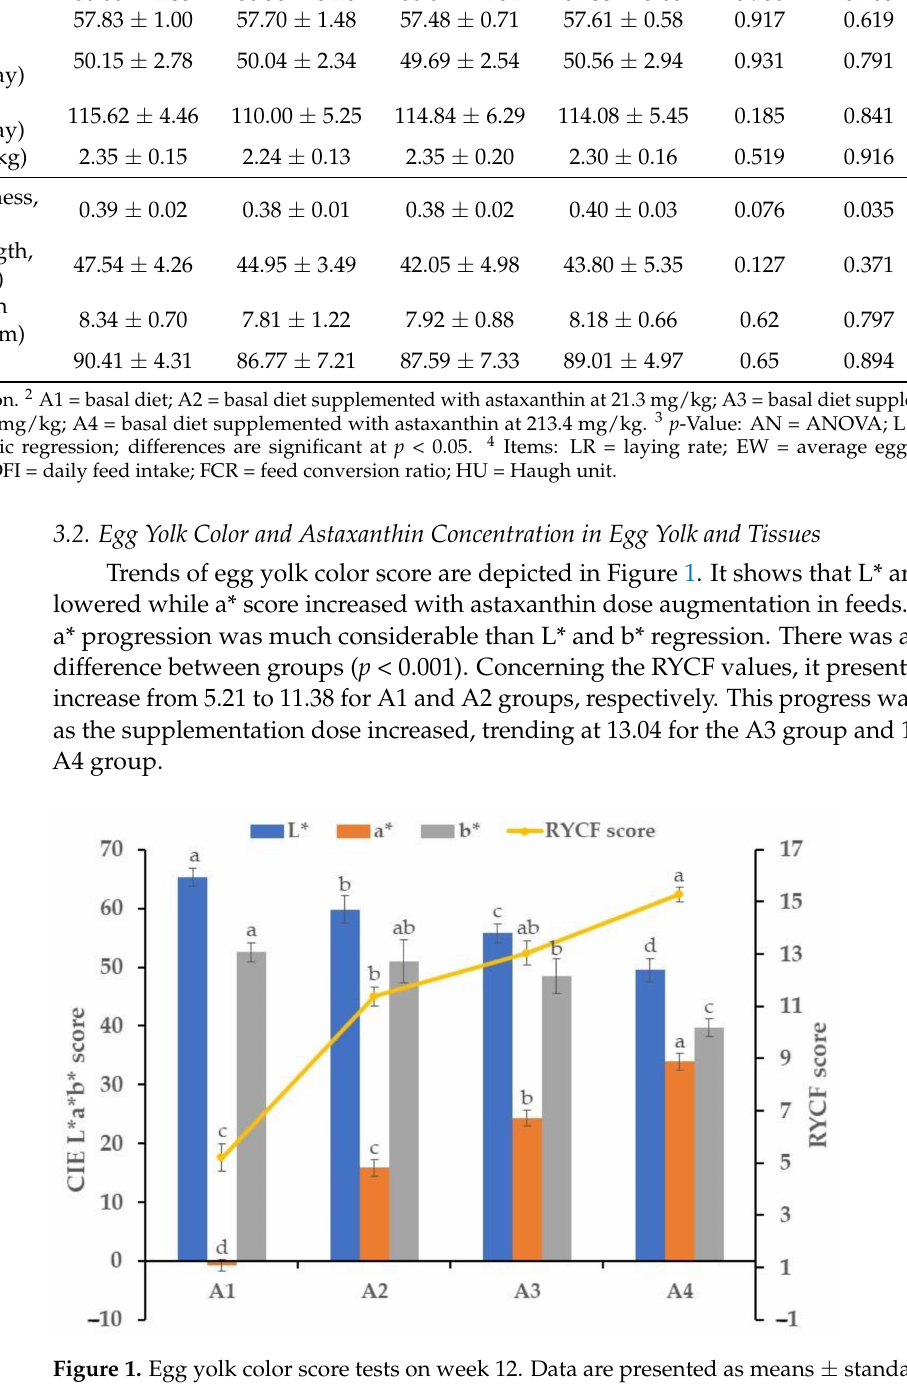
Figure 1. Egg yolk color score tests on week 12. Data are presented as means ± standard deviation (n = 8). a–d: different superscript letters within a same pattern indicate significant difference between groups ( p < 0.05). A1, A2, A3, A4 = group supplemented with astaxanthin at 0 mg/kg, 21.3 mg/kg, 42.6 mg/kg, 213.4 mg/kg of diet, respectively. CIE L*a*b* score = International Commission on Illumination score where L* = lightness, a* = redness, and b* = yellowness. RYCF score = Roche yolk color fan